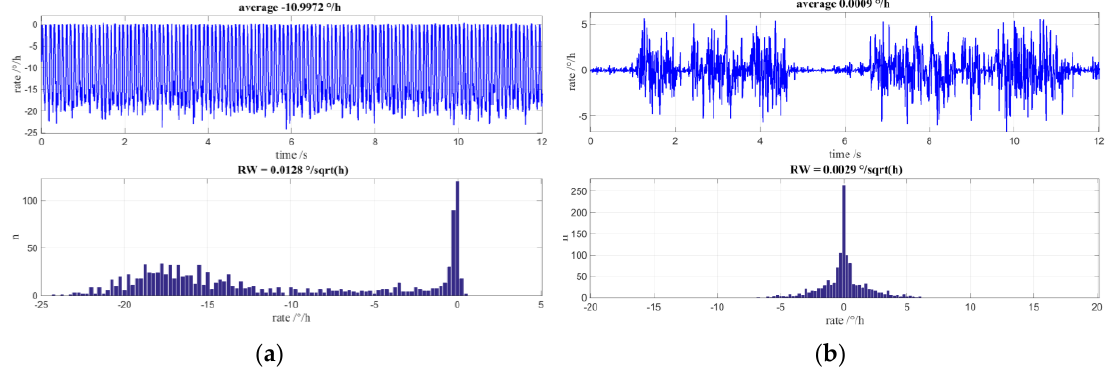
Figure 10. Simulations including non-ideal MIOC transfer function; the dithering for auxiliary gain control loop is off to emphasize the effects of MIOC phase bleed: ( a ) Simulated time signal and value distribution histogram for a low applied rotation rate of approximately −10°/h; ( b ) Simulated time signal and value distribution histogram for applied rotation rate of 0°/h.